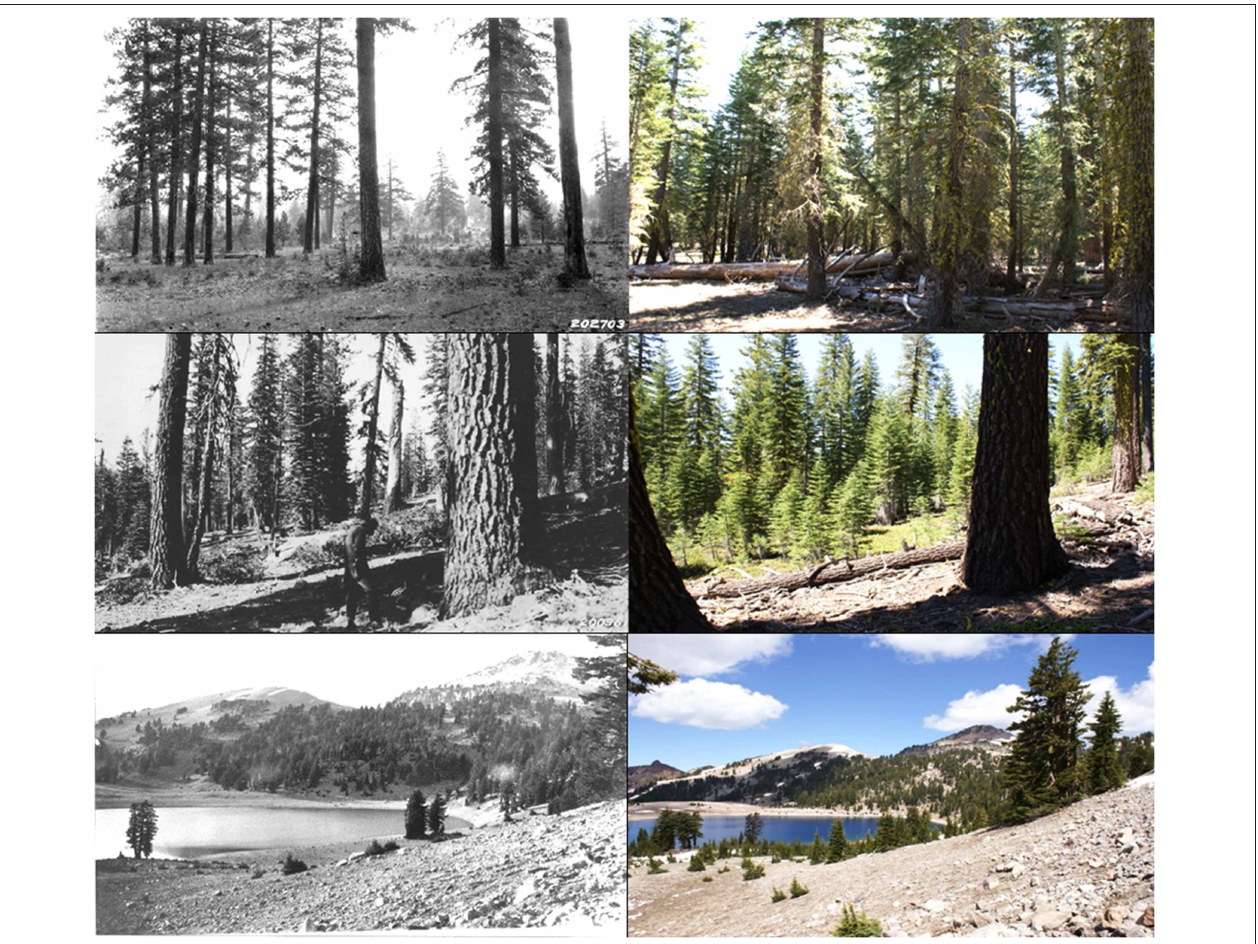
FIGURE 9 | Twentieth century forest changes in dry, mesic, and cold conifer forests in repeat photographs along an elevation-fire frequency gradient in the Southern Cascades, California. Fire regimes changed across the region after 1905 when fire suppression was implemented. Changes in tree density and species composition caused by fire suppression are more evident in dry (Top left, Weislander, 1925; Top right, Alan Taylor, 2008) and mesic (Middle left, Weislander, 1925; Middle right, Alan Taylor, 2009) forests that burned more frequently, than in cold (Bottom left, Blair, 1934; Bottom right, Alan Taylor, 2009) forests. Forests have not been logged and the photographs were taken in Lassen Volcanic National Park at referenced markers. Additional details on fire regimes and forest changes in the Southern Cascades can be found in Skinner and Taylor